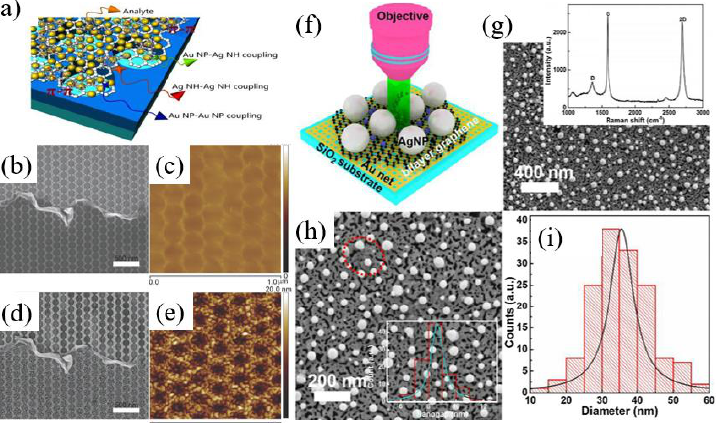
Figure 4. ( a ) The scheme of Ag NPS/graphene/Ag NHs structure. ( b , c ) The SEM image and the AFM images of graphene/Ag NHs structure. ( d , e ) The SEM image and the AFM images of Ag NPS/graphene/Ag NHs structure. Reprinted from Ref. [46] with permission of 2017 Royal Society of Chemistry. ( f ) Schematic illustration of Ag NPs/bilayer graphene/Au nanonet SERS composite substrate. ( f ) SEM image of Ag NPs/bilayer graphene/Au nanonet SERS samples. Inset: The Raman spectrum of graphene. ( g ) The high-magnification SEM image of Ag NPs/bilayer graphene/Au nanonet SERS samples. ( i ) Size distribution of 150 Ag NPs counted from ( h ). Reprinted from Ref. [78] with permission of 2018